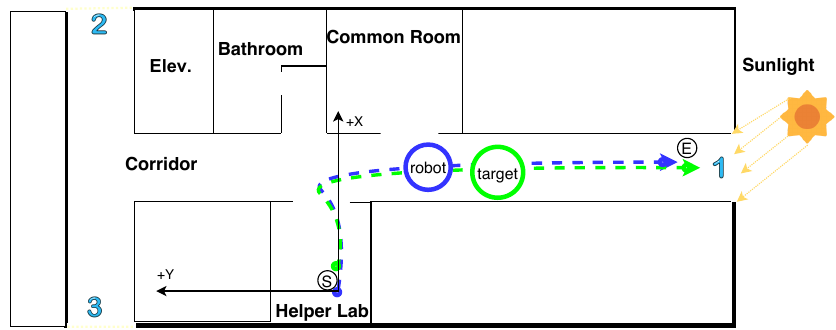
Figure 10. Realistic scenario of paths of the robot and the target for recovery